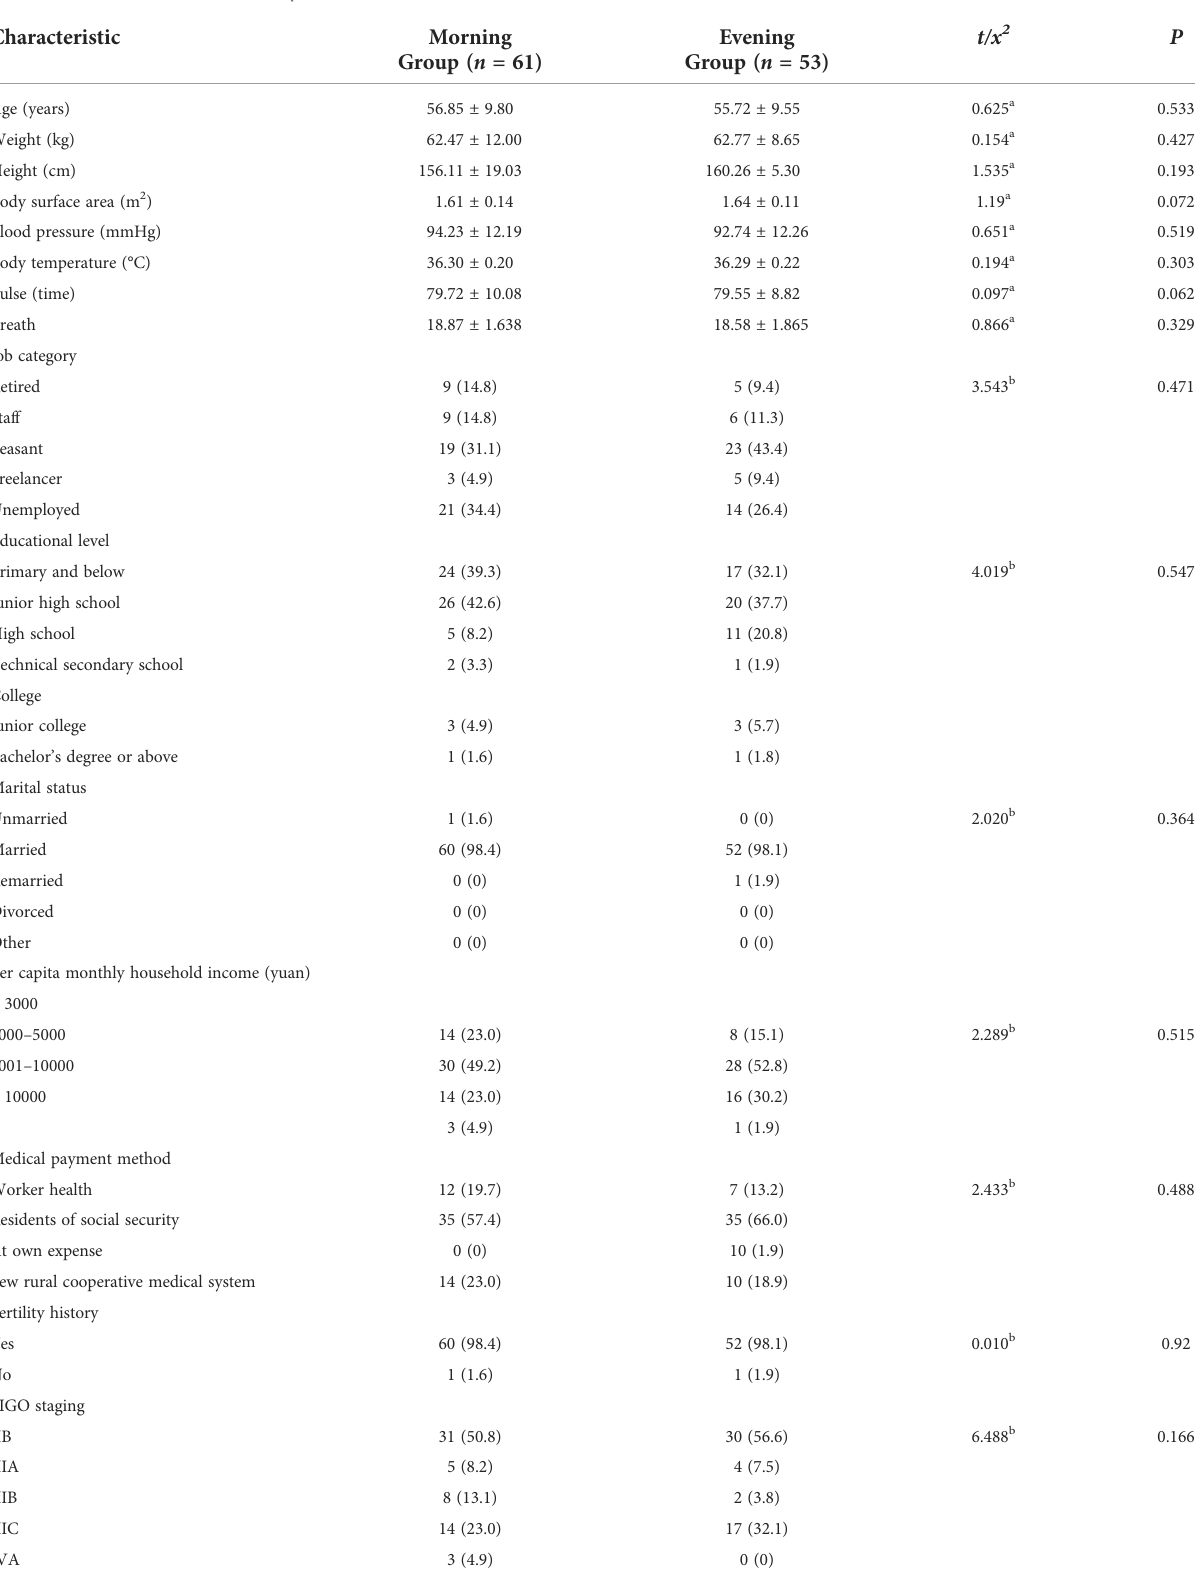
TABLE 3 Baseline characteristics of